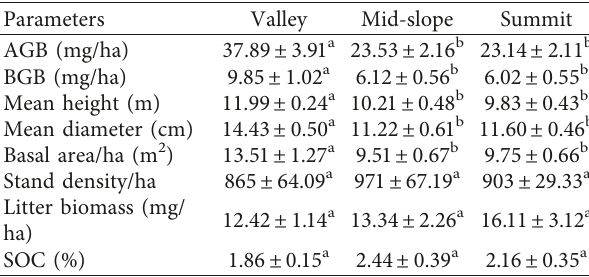
Table 2: A comparison of stand parameters at three different el- evations for a 7-year-old teak plantation. The values are means and their associated standard